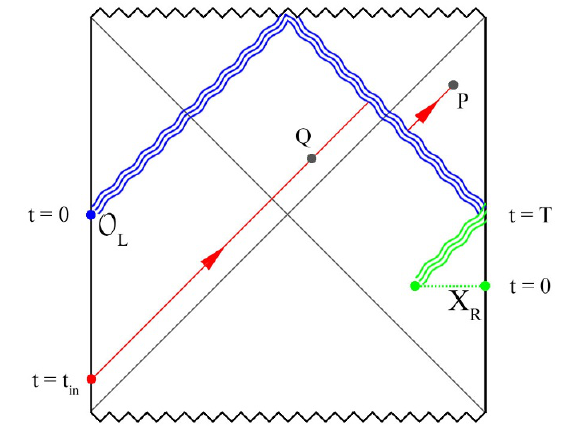
Figure 5 . Local operators at points P; Q are